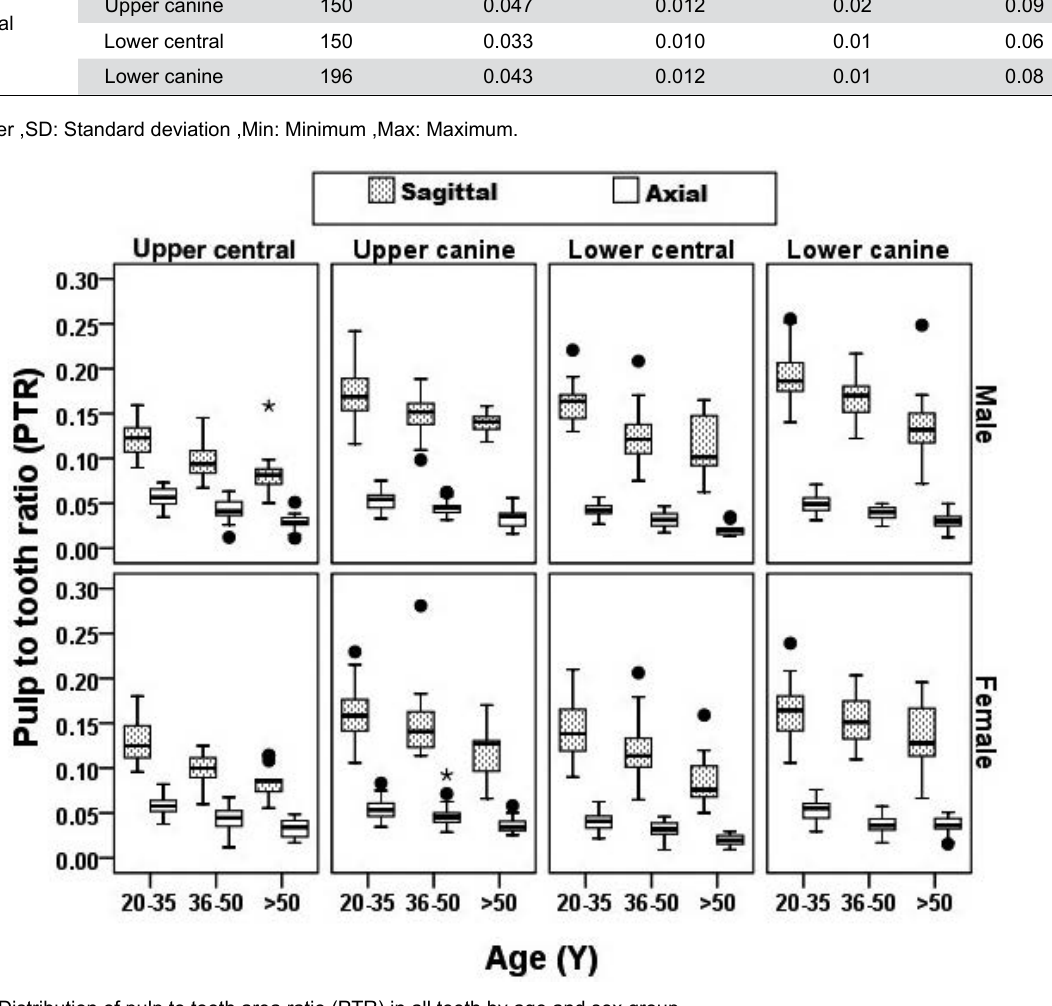
Figure 2- Distribution of pulp to tooth area ratio (PTR) in all teeth by age and sex